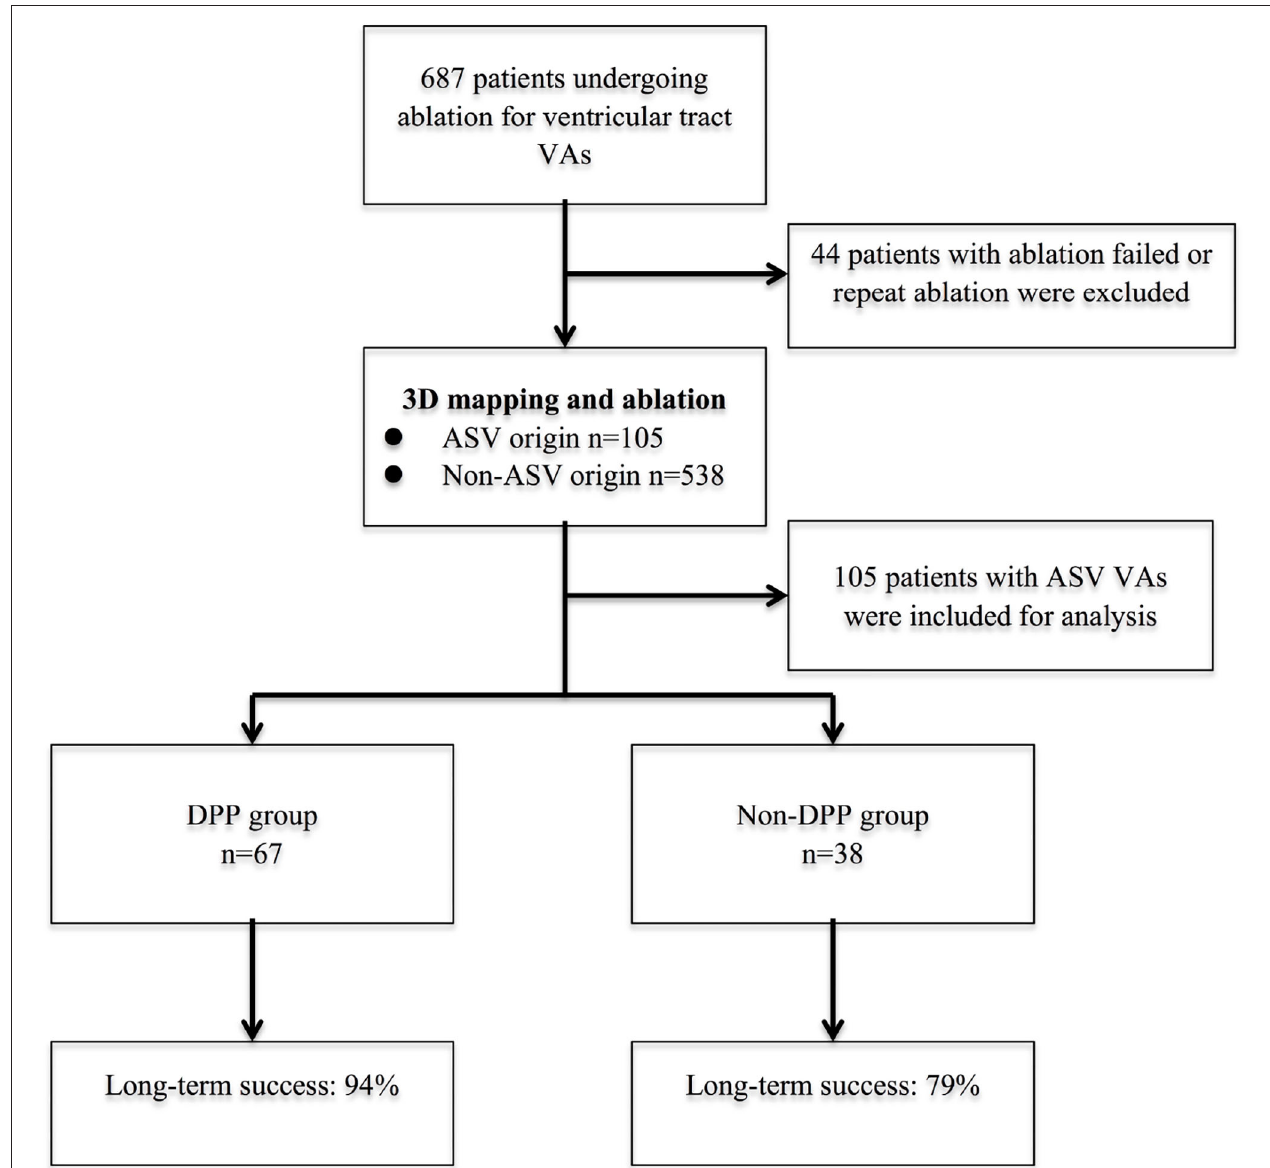
FIGURE 1 | The flow diagram of the study and long-term success rate. 3D, 3-dimensional; ASV, aortic sinus of Valsalva; DPP, discrete pre-potential; VA, ventricular